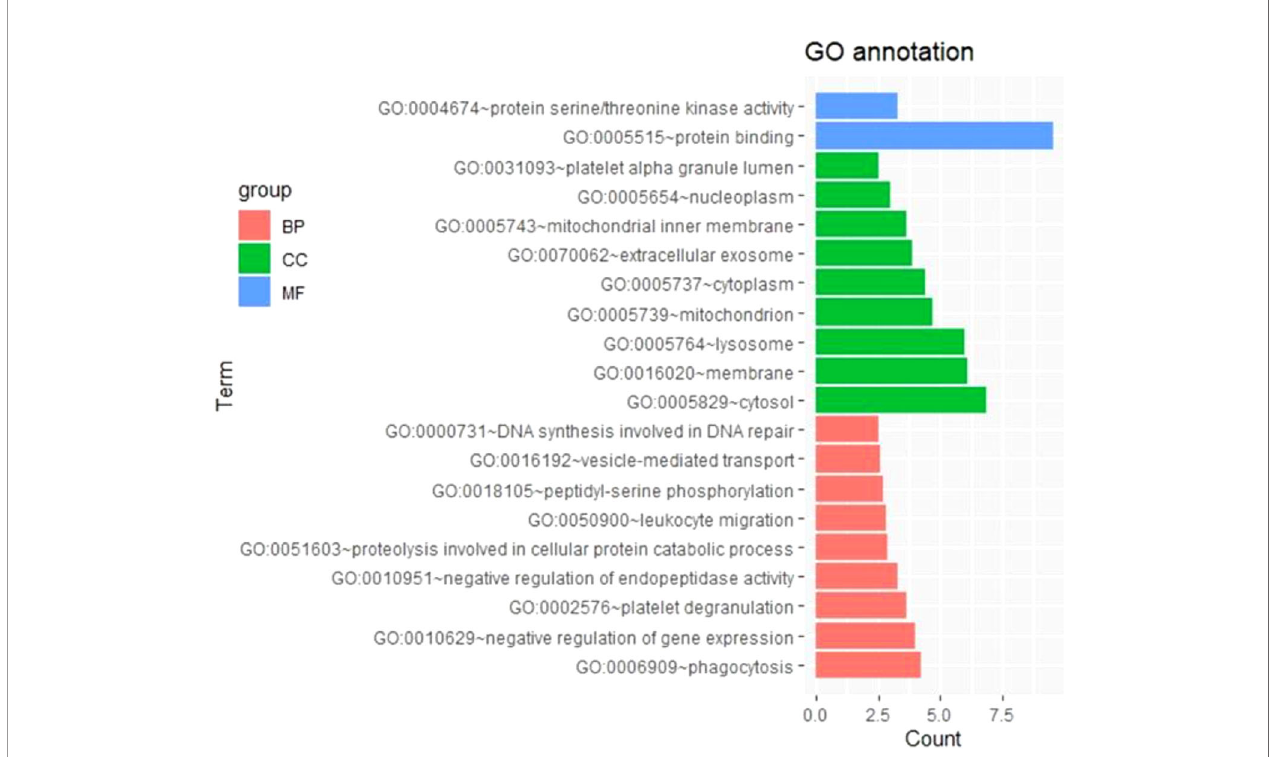
FIGURE 2 | GO enrichment analysis displayed genes respond to m 6 A-cis-eQTLs are enriched in various biological processes (BP), molecular function (MF) and cellular component (CC). Note that platelet degranulation (BP) and platelet alpha granule lumen (CC) are signi fi cant pathway.